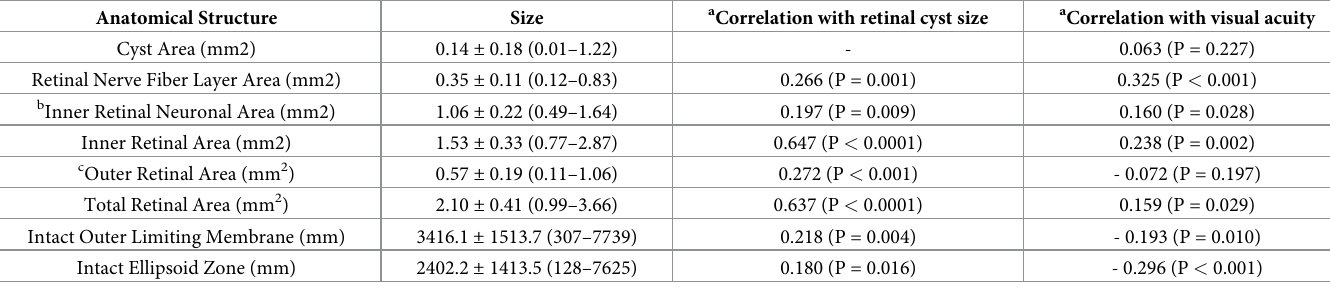
Table 2. Correlations of anatomical and functional parameters.